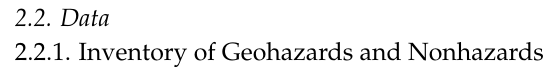
Figure 1. Location of the study